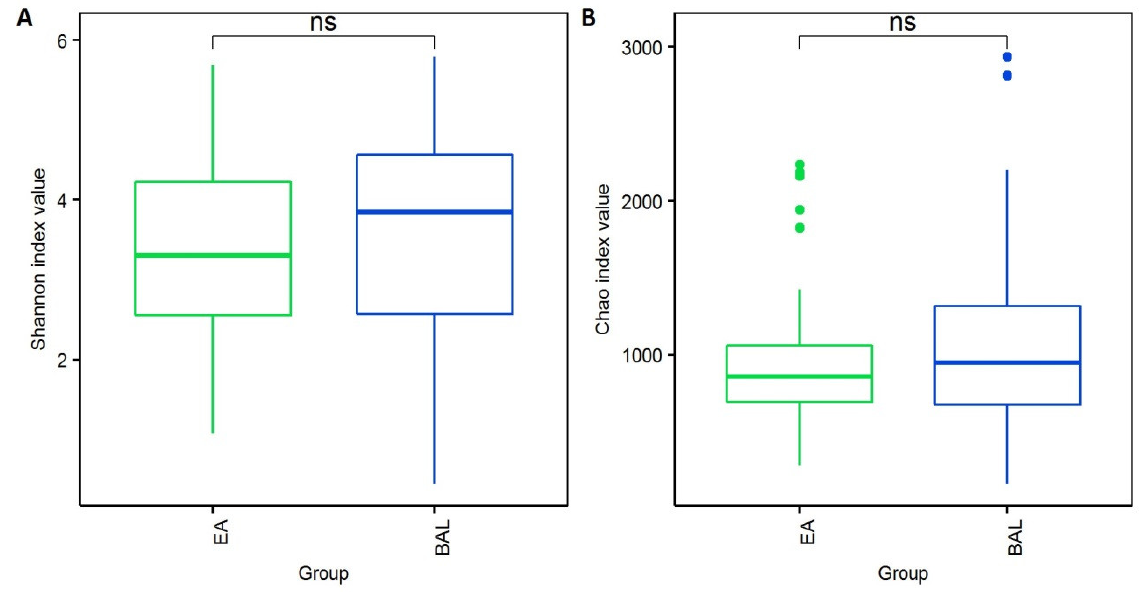
Figure 3. Comparison of the microbial diversity between the EA and BAL samples according to ( A ) the Shannon index and by ( B ) the Chao index. ns: no significant difference.